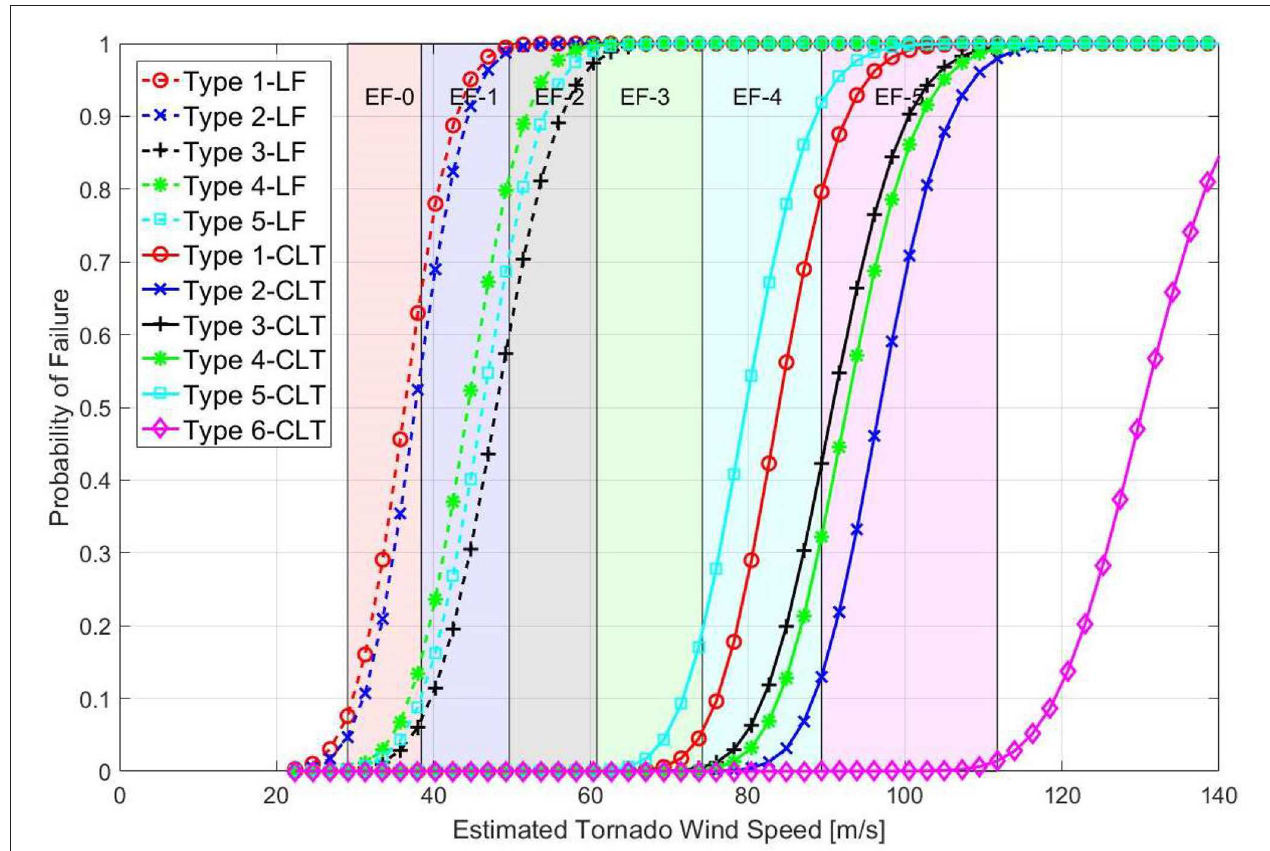
FIGURE 10 | Simulated performance of all structure types compared to light-frame